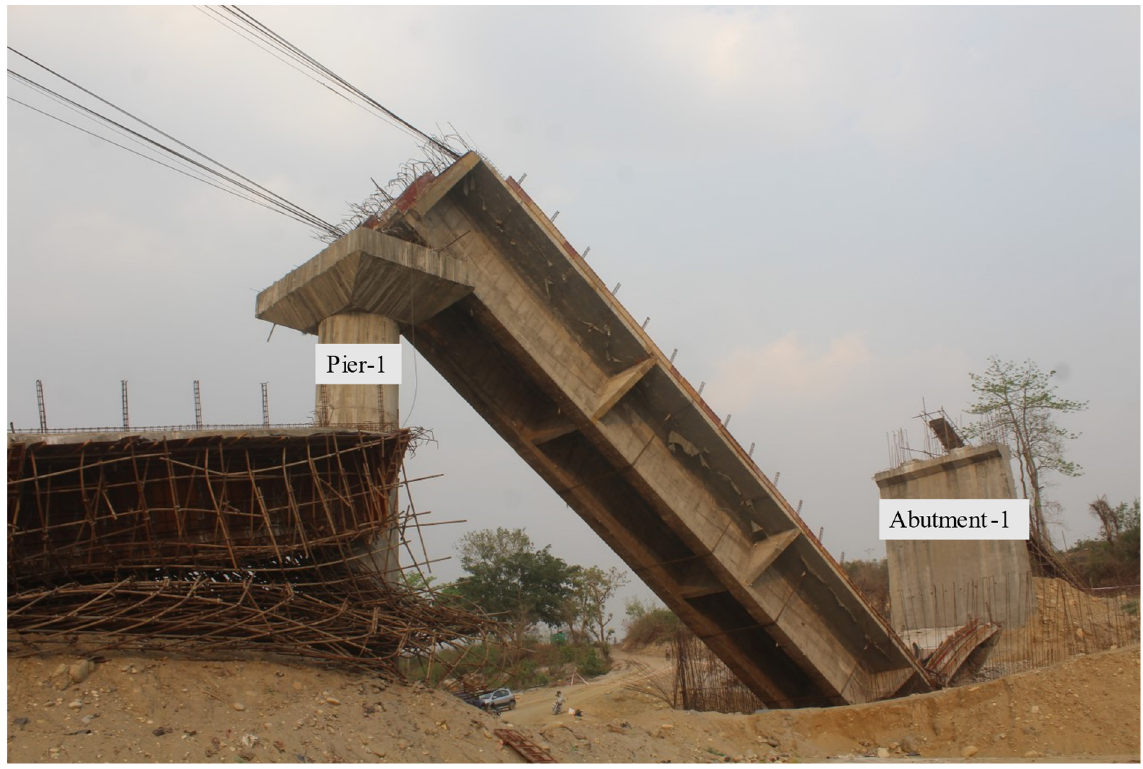
Figure 4. Collapsed first span of the bridge.